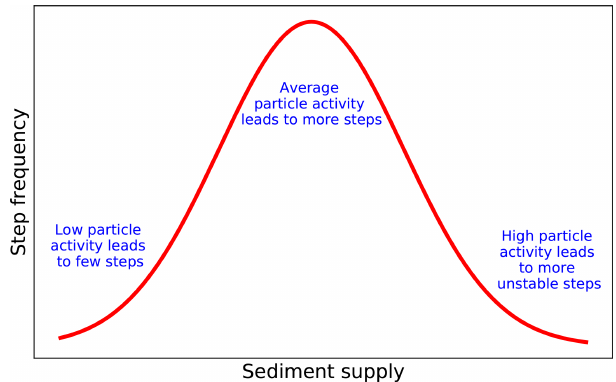
Figure 1. Conceptual model that shows step frequency as a function of sediment supply (i.e., particle